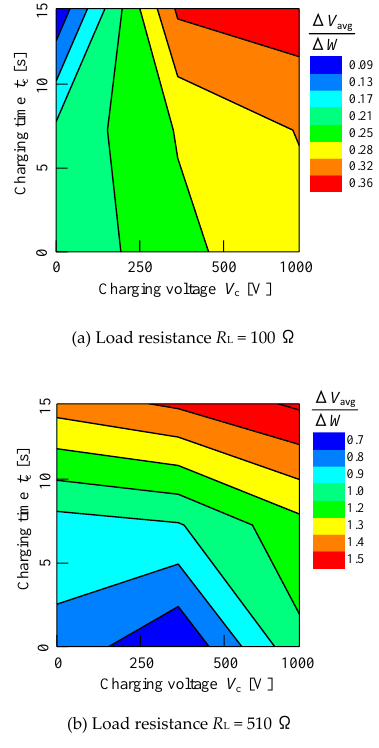
analysed from the ratio of voltage difference ∆ V avg to moisture content difference ∆ w according to the colour region. For example, for the blue colour, the sensitivity of the sensor increases eight times from load resistance R L is 100 Ω to 510 Ω. As for the red colour, the sensitivity increases four times as load resistance R L increases. Hence, the overall sensitivity in this study increases, as can be seen in 250 V, 500 V and 1000 V.